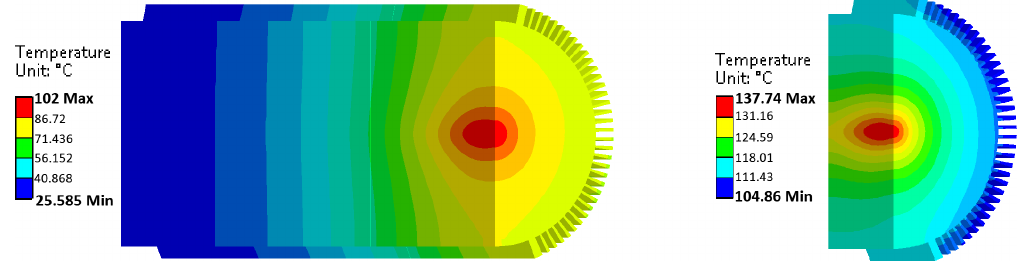
FIG. 11. Steady state temperature distributions achieved in the dump core for the two models taken into consideration under prolonged dumping of a 2 GeV NORMGPS beam with an intensity of 1 × 10 14 ppp at a 50% dumping rate. On the left, the continuous dump model. On the right, the model assuming the first block